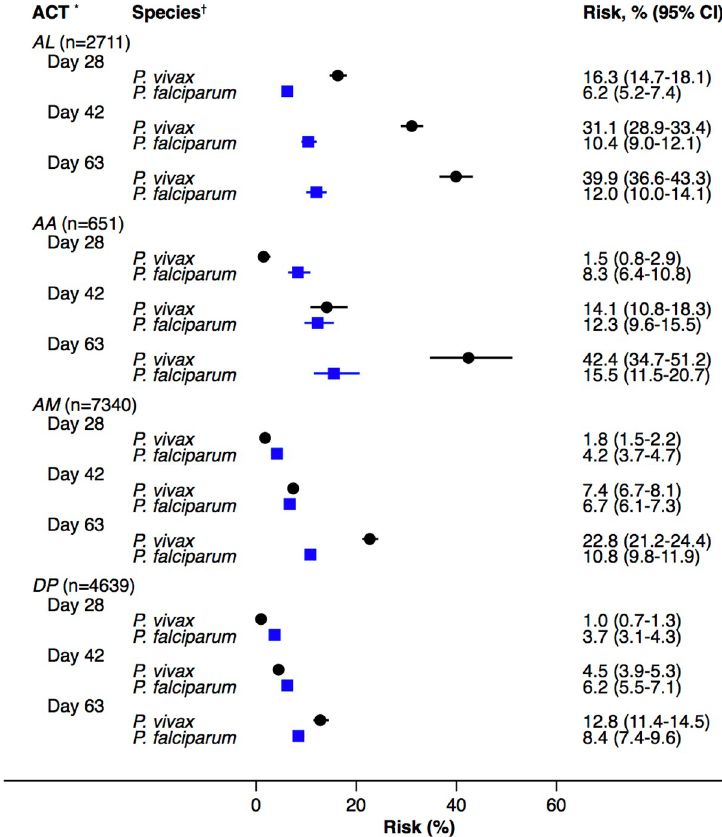
Fig 2. Cumulative risk (Kaplan–Meier analysis) of P . vivax parasitaemia following ACTs. � ACTs (AA, AL, AM, DP). † P . vivax recurrence includes recurrences with P . vivax monoinfection or mixed-species infection. AA, artesunate-amodiaquine; ACT, artemisinin-based combination therapy; AL, artemether-lumefantrine; AM, artesunate-mefloquine; DP, dihydroartemisinin-piperaquine.